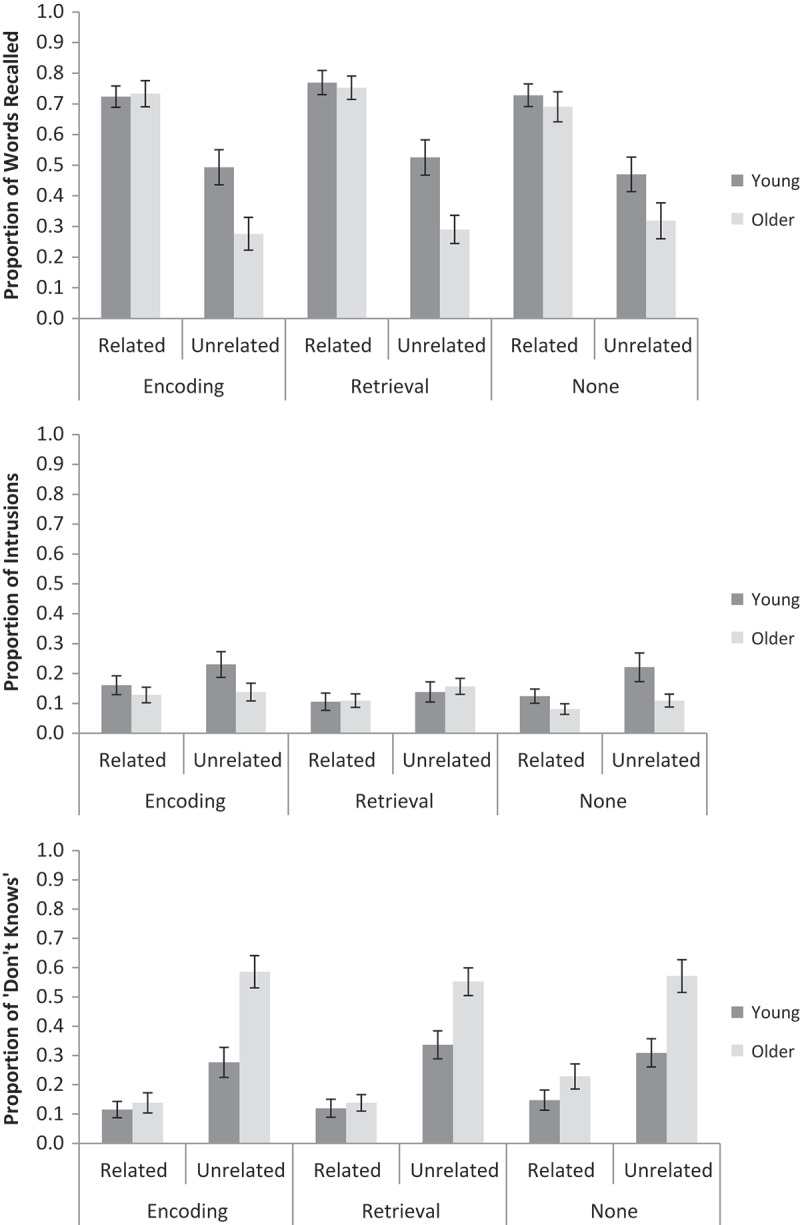
The proportion of words correctly recalled (top), intrusions (middle) and “don’t know” responses (bottom) for related and unrelated word pairs, for labels at encoding, retrieval or no labels, and for young and older adults in Experiment 2. Error bars are ±1 SE.